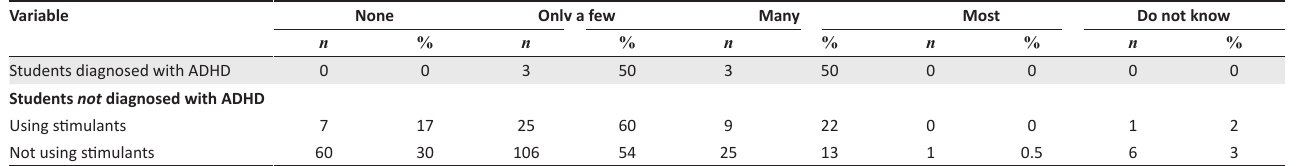
TABLE 4: Students opinion on university’s attitude. † Variable Discourage